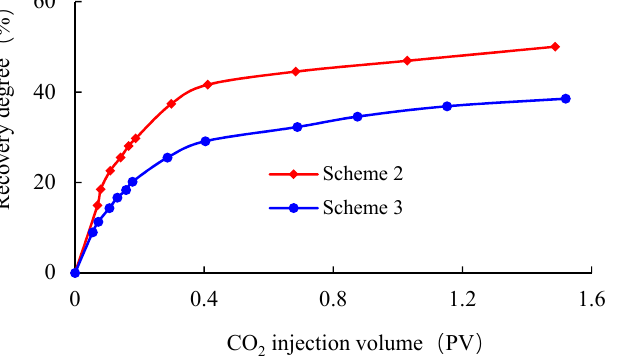
Figure 19. The relationship between CO 2 injected volume and recovery degree (Scheme 2 and Scheme 3).